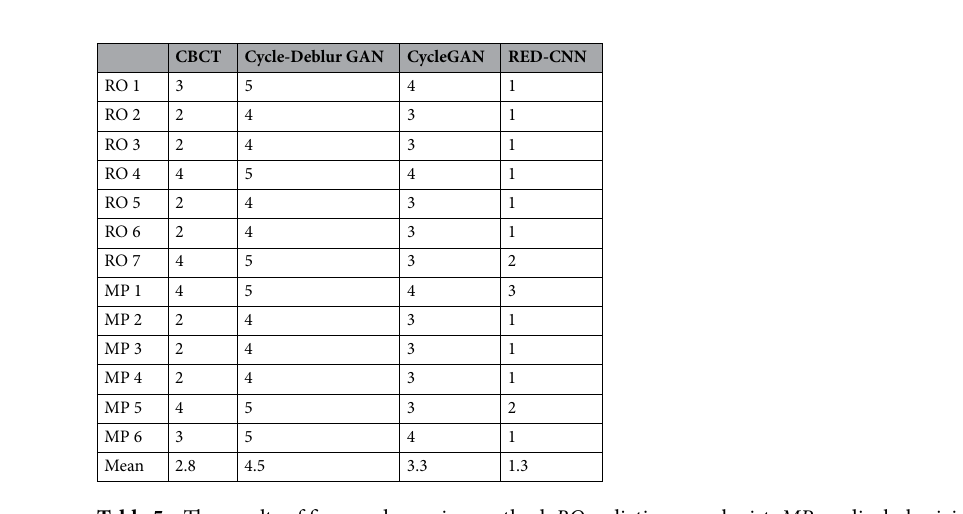
Table 5. The results of five-grade scoring method. RO radiation oncologist, MP medical